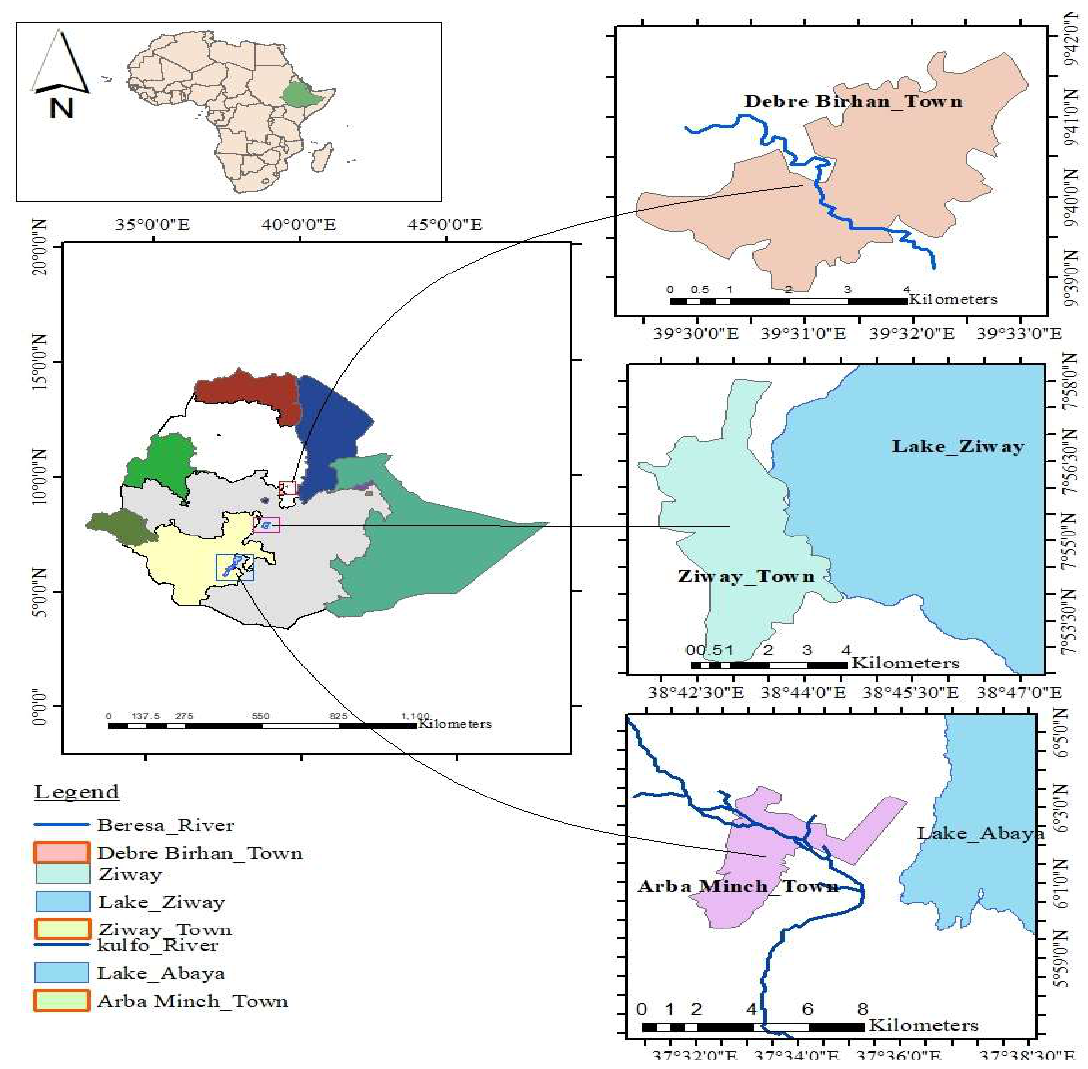
Figure 1. Study area location map .